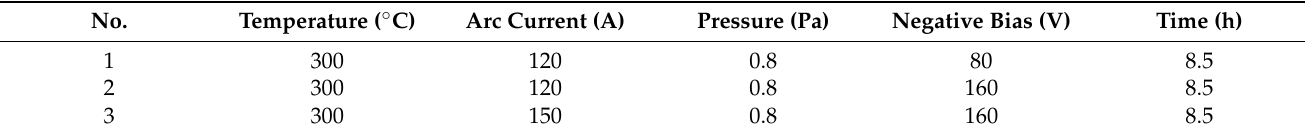
Table 1. The process parameters of multi-arc ion plating.